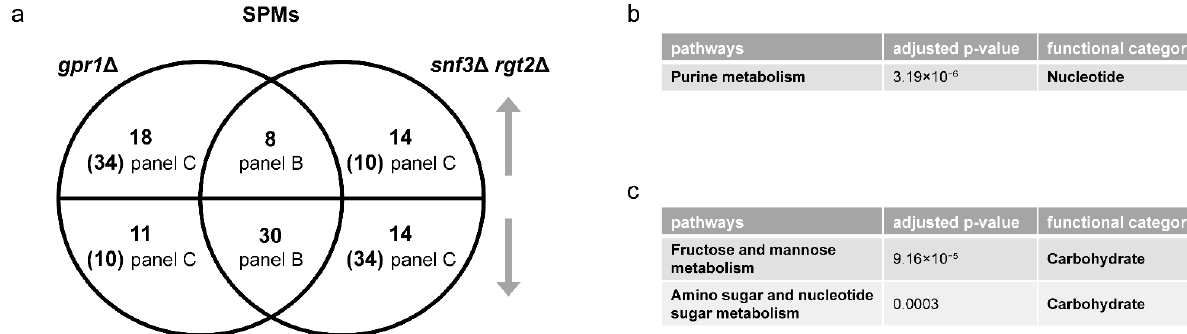
Figure 3. Comparing significantly perturbed metabolites (SPMs) of gpr1 Δ and snf3 Δ rgt2 Δ . ( a ) Venn diagram of subsets of SPMs, for gpr1 Δ vs. wildtype and snf3 Δ rgt2 Δ vs. wildtype, after glucose addition. Upper semicircle shows up-regulated SPMs and lower semicircle shows down-regulated SPMs. Numbers in the overlapping region are shared SPMs regulated in the same direction. Numbers in parenthesis are shared SPMs regulated in the opposite direction, and are placed in the area corresponding to the direction of regulation. SPMs used for ORA analysis that are ( b ) shared and change in the same direction; ( c ) shared and change in the opposite direction. Listed are all pathways and their functional categories with adjusted p -value < 0.05.